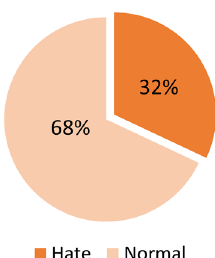
Fig. 2 Ratio of hate tweets vs normal tweets in arHate-